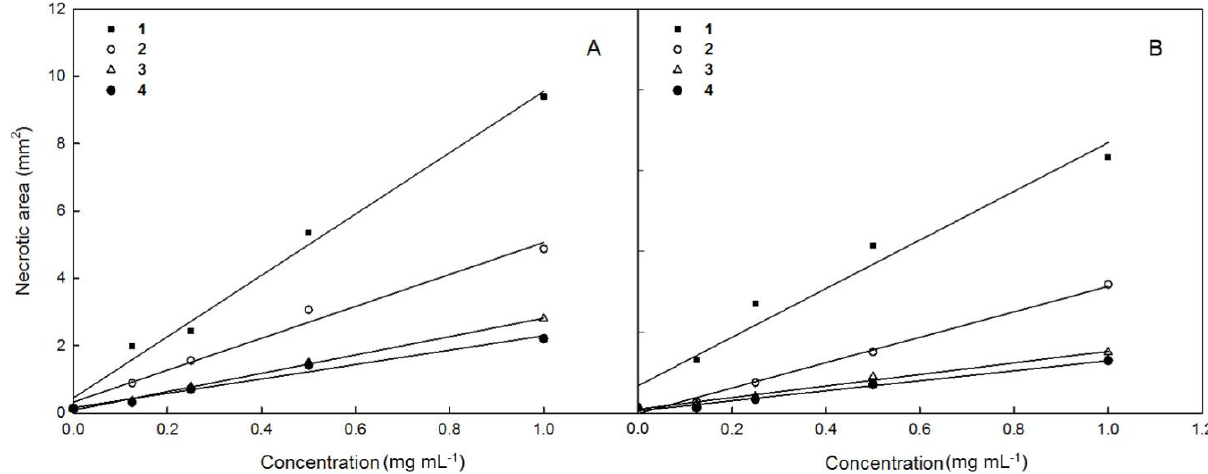
Figure 5. Linear association comparison between necrotic areas (NA) and concentrations (Conc) of assayed compounds under dark (A) and light (B) conditions. In the dark and for compound 1 , NA = 0.44 + 9.11conc; R 2 = 0.99, P <0.001: for 2 , NA = 0.32 + 4.74conc; R 2 = 0.99, P <0.001: for 3 , NA = 0.08 + 2.73conc; R 2 = 0.99, P <0.001: for 4 , NA = 0.15 + 2.13conc; R 2 = 0.98, P <0.001. In the light and for compound 1 , NA = 0.67 + 6.03conc; R 2 = 0.96, P <0.001: for 2 , NA = -0.01 + 3.15conc; R 2 = 0.99, P <0.001: for 3 , NA = 0.09 + 1.43conc; R 2 = 0.99, P <0.001: for 4 , NA = 0.05 + 1.24conc; R 2 = 0.99, P